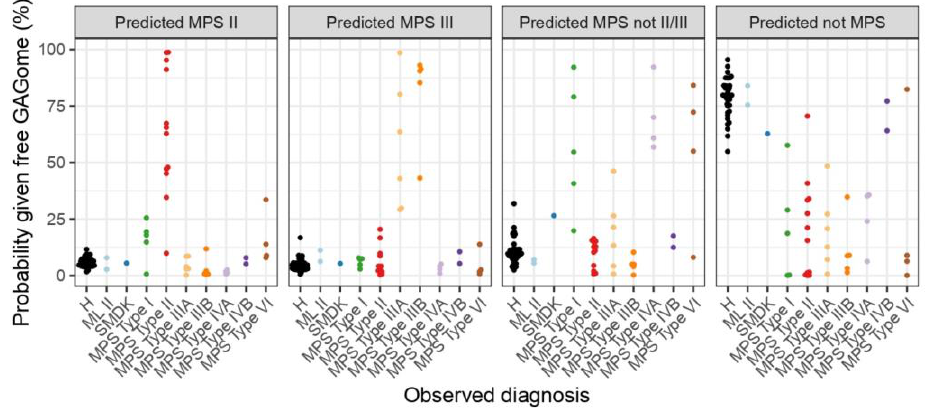
Figure 4. Prediction probability (in %) for each class as obtained by the prediction model developed for differential diagnosis of MPS subtypes, given the urine free GAGome measurements as inputs, vs. the observed diagnosis. SMDK: spondylometaphyseal dysplasia-Kozlowski type. ML II: mucolipidosis type II. Table 2. Clinical performance of each binary test in the prediction model developed for differential diagnosis of MPS subtypes given urine free GAGome measurements as input. TP: true positive, TN: true negative, FP: false positive and FN: false negative.